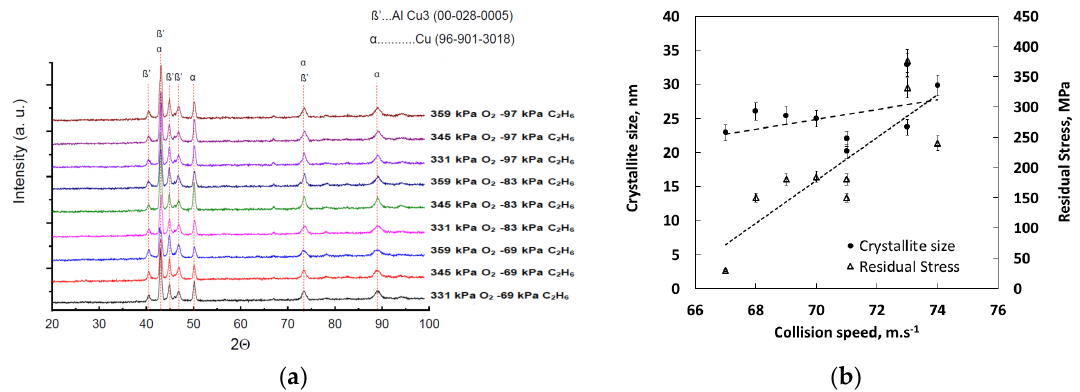
Figure 3. ( a ) X-ray diffraction (XRD) of the nine combinations of oxygen and acetylene feed pressures for the aluminum-bronze coatings, ( b ) Results of the crystallites size and residual stresses vs. the collision velocity of particles (the trend lines are shown as a visual aid).